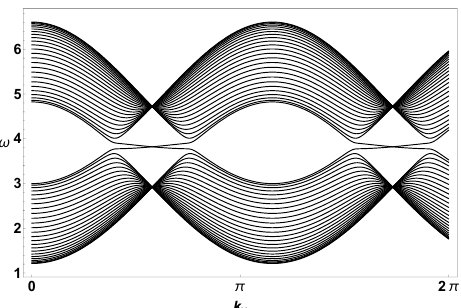
= 1, J = 0.9, J = 0.6, ± ±± zz